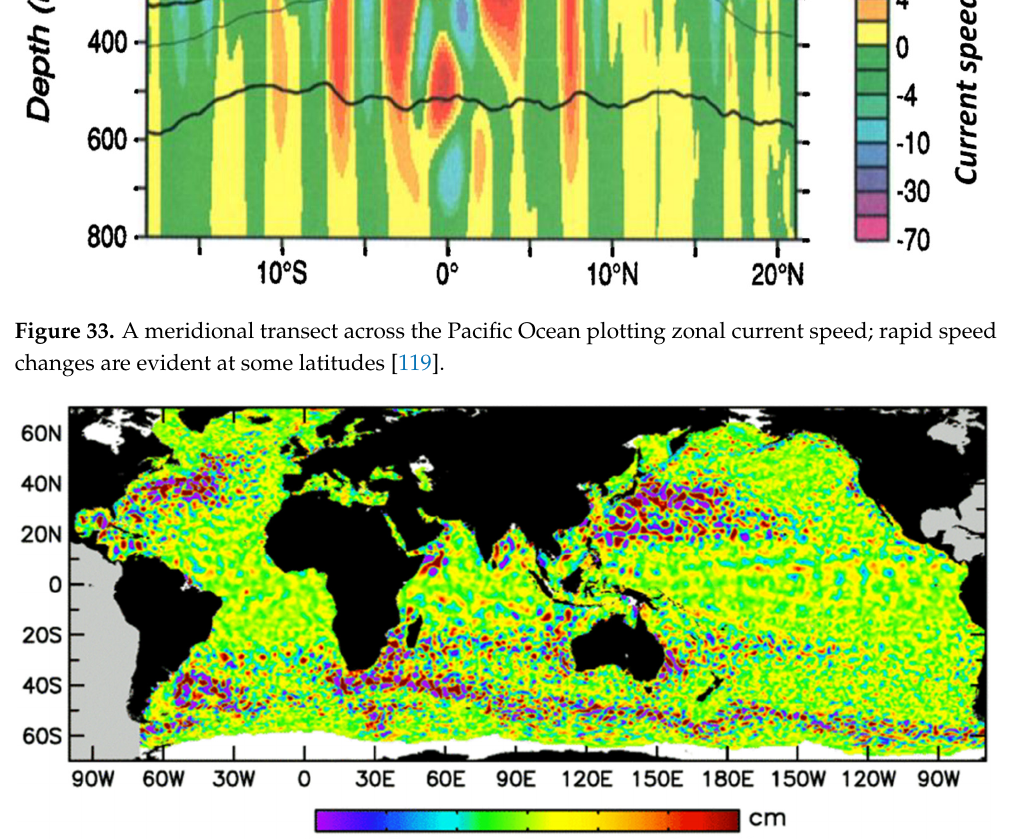
Figure 34. A snapshot of the spatial distribution of strong mesoscale eddies. Note the dominance of eddy shedding by western boundary currents.